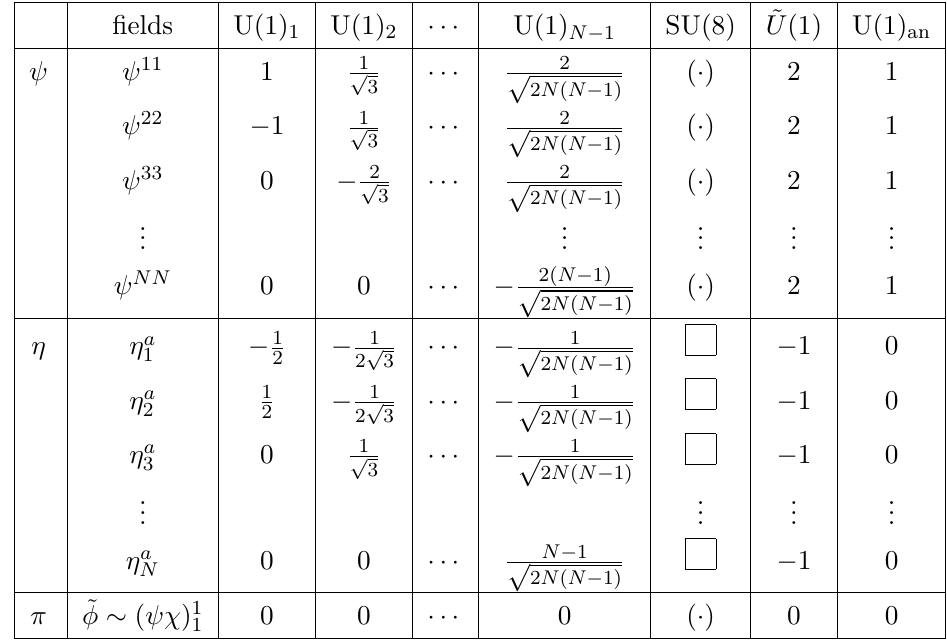
Table 2 . Massless fermions in the infrared in the ψχη model and their charges with respect to the unbroken symmetry groups. The massless NG boson carries no charges with respect to the unbroken symmetries, see section 3.2. The two (nonanomalous and anomalous) U(1) symmetries ˜ U (1) and U(1) an which are not affected by the ψχ condensate are defined in (2.7). u (1) N − 1 ⊂ su ( N ) are taken in Cartan subalgebra, satisfying the orthogonality relations, Tr( T a T b ) ∝ δ ab